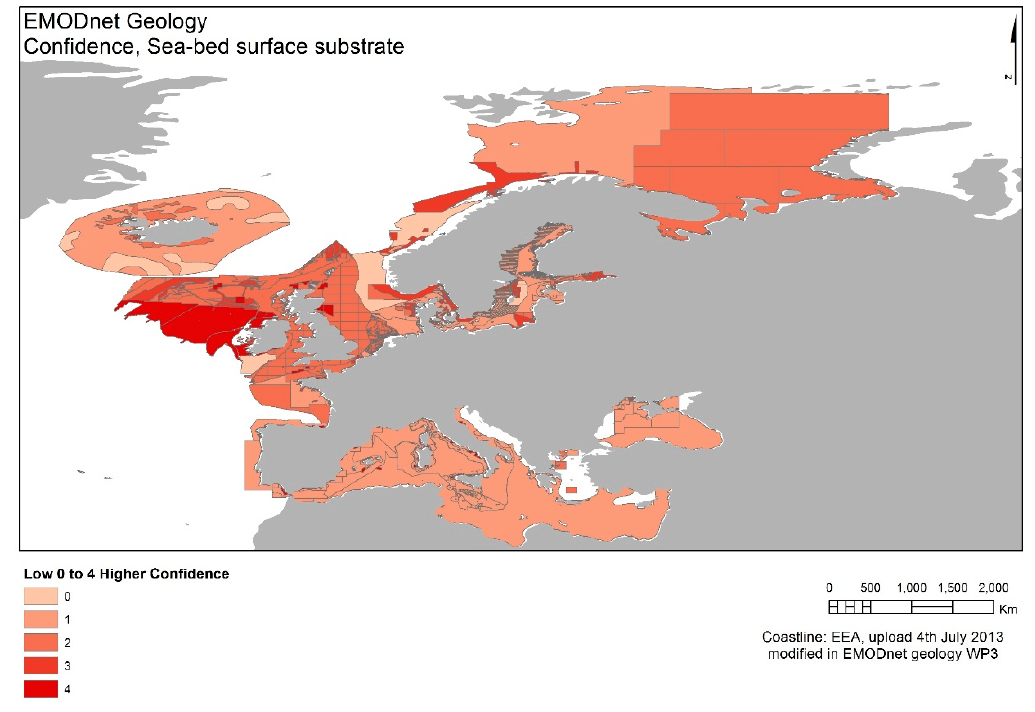
Figure 9. Confidence map of EMODnet Geology study area for seabed substrate map (1 M scale).